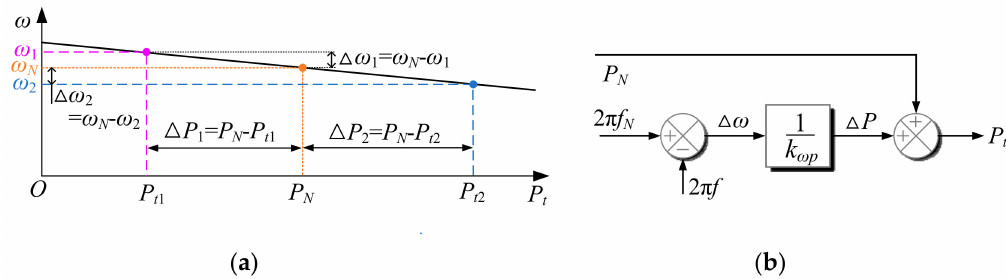
Figure 3. Explanations of f - P controller. ( a ) Relation between the output mechanical power and angular speed for a generator; ( b ) Structure of an f - P